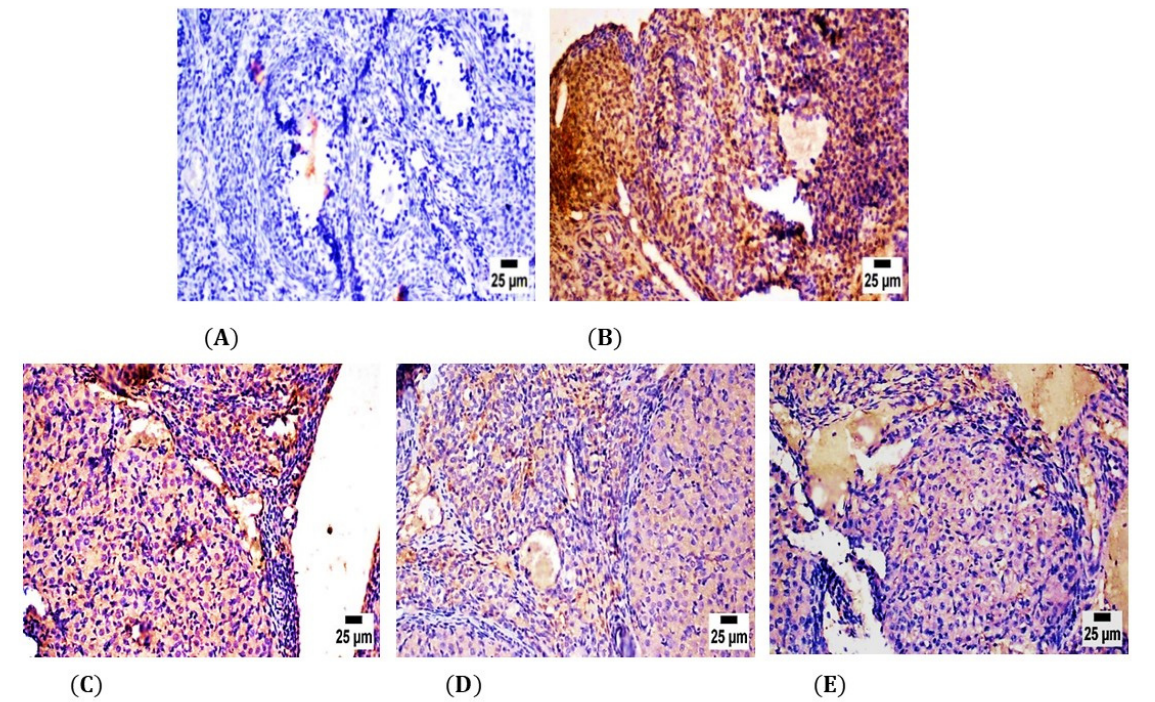
Figure 5. Photomicrographs of the ovarian tissue sections of the control and experimental groups. ( A ) showing negative secretion of TNF- α polyclonal antibodies in the self-control group. ( B ) The CPA-treated group showed strong positive expression of TNF- α polyclonal antibodies. ( C ) The LPE-treated group showed moderate expression of TNF- α polyclonal antibodies. ( D ) RES group showed lower expression of TNF- α polyclonal antibodies. ( E ) LPE + RES showed minimal production of TNF- α polyclonal antibodies. CPA: Cyclophosphamide, LPE: Lemon peel extract, RES: resveratrol.